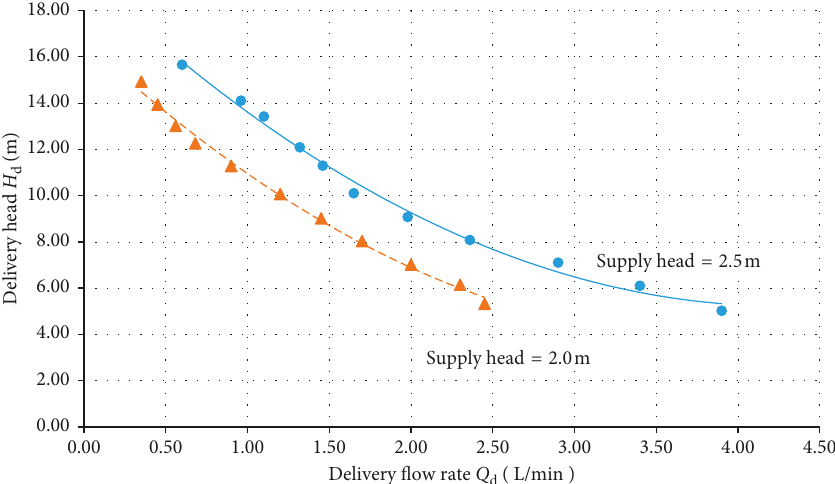
Figure 4: Delivery head vs. delivery flow rate at difference head, h